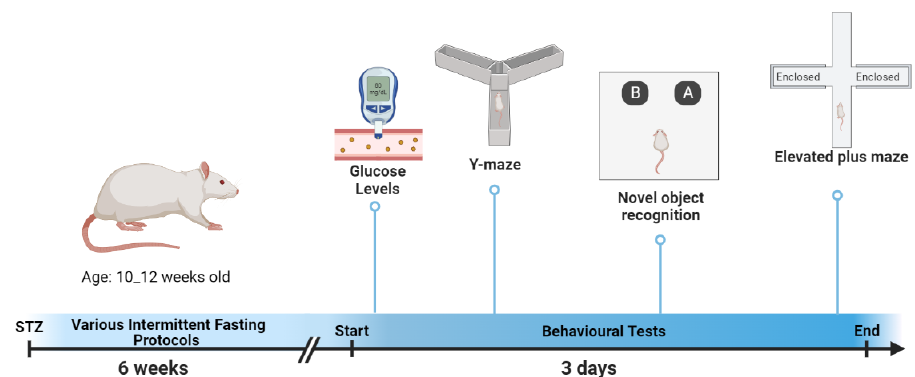
Figure 1. Conceptual diagram explaining the timeline of the study starting from the diabetes induc- induction to conducting all tion to conducting all experiments.